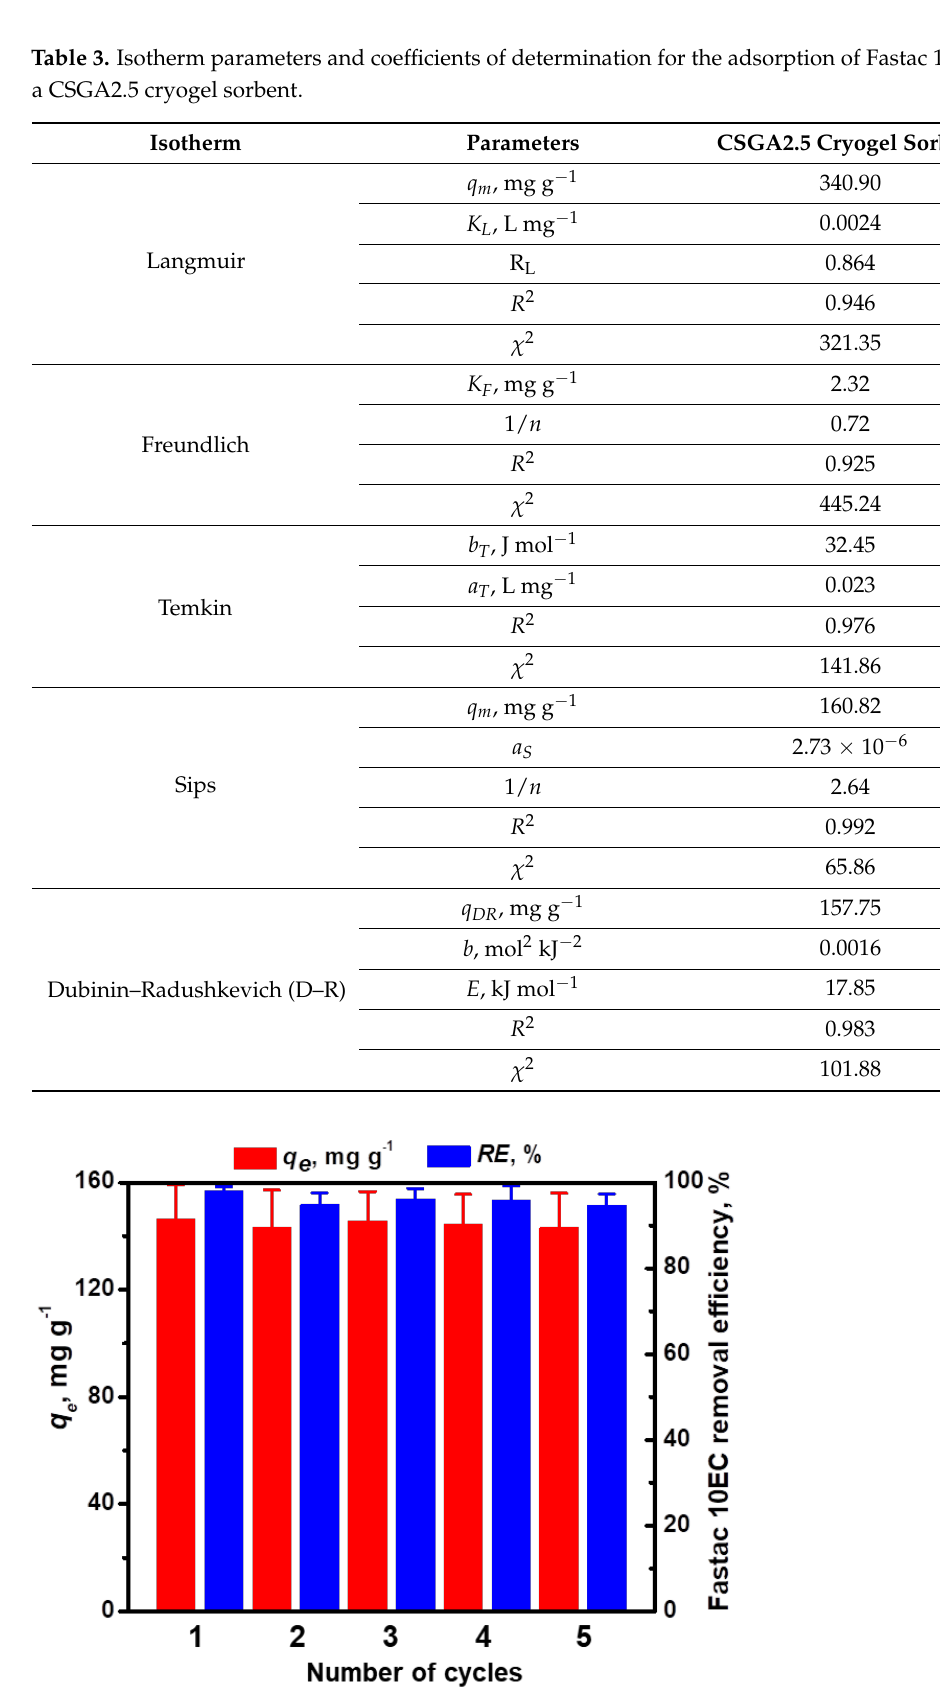
Figure 7. Reusability of CSGA2.5 cryogel sorbents for Fastac 10EC removal (pH 6, a sorbent dose